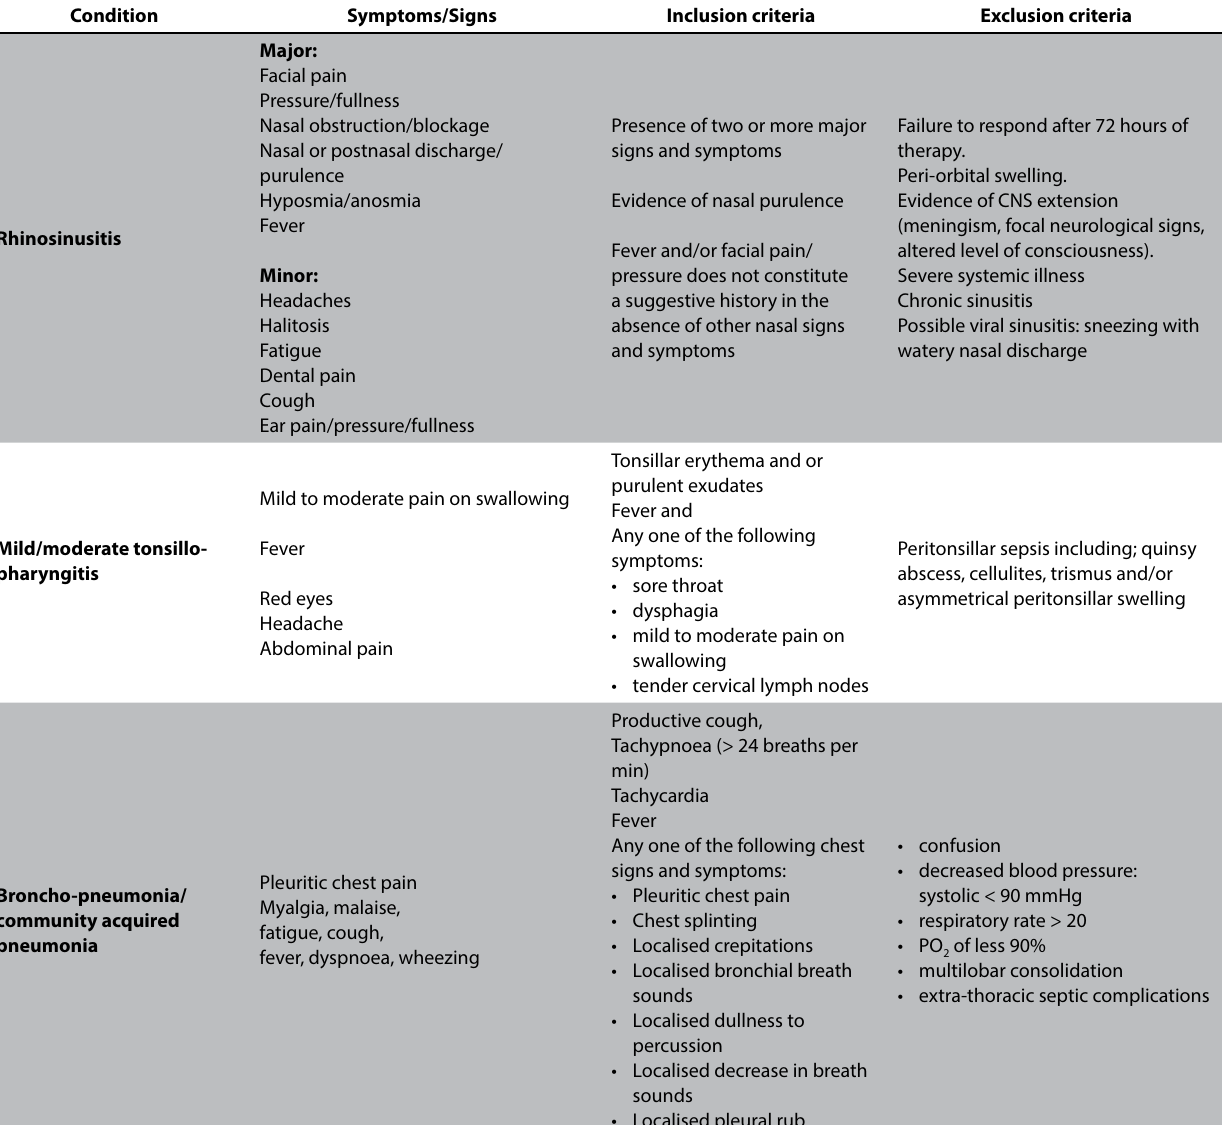
active against penicillin-susceptible